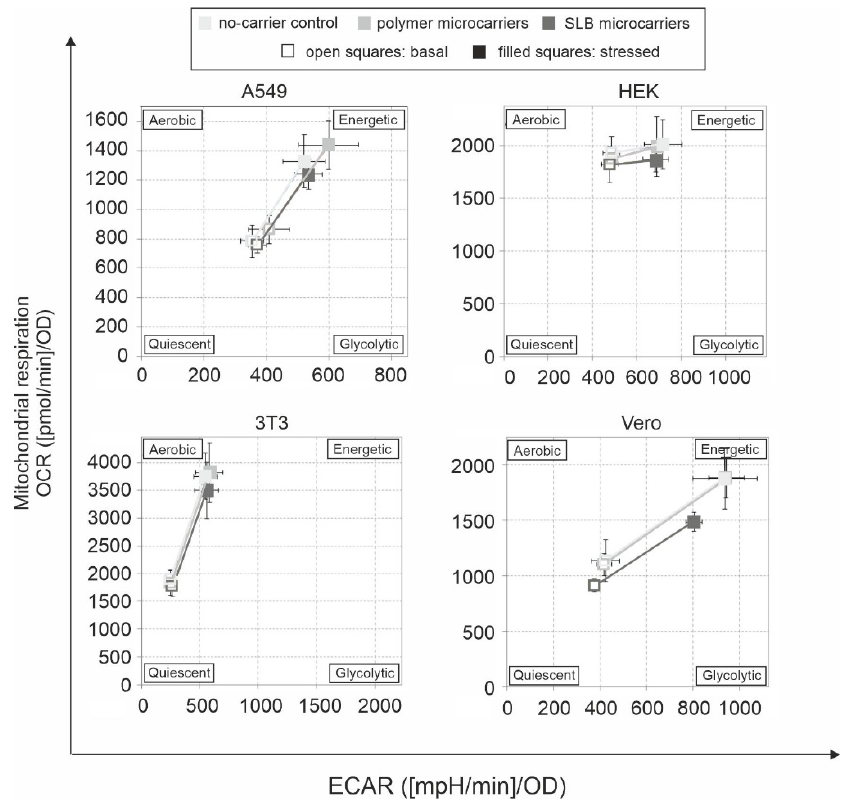
Figure 3. Cell energy phenotype for all examined cell lines incubated in the presence and absence of microcarriers. Energy maps were generated by the cell energy phenotype test kit based on OCR vs ECAR values obtained under basal and stressed conditions to reveal changes in energy maps after application of polymer and SLB microcarriers.